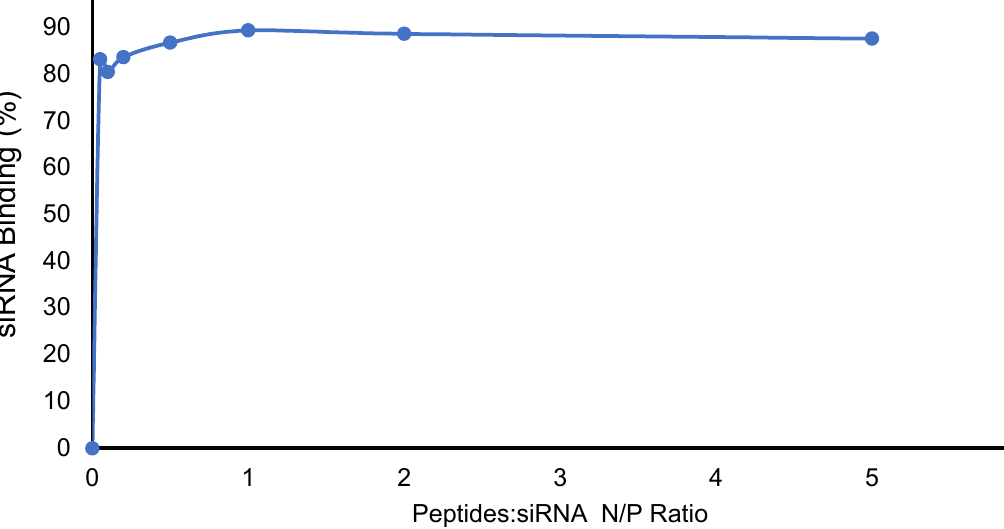
Figure 3. Binding affinity of the peptide to scrambled siRNA, indicating the percentage of siRNA bound to the peptide at different N/P ratios.